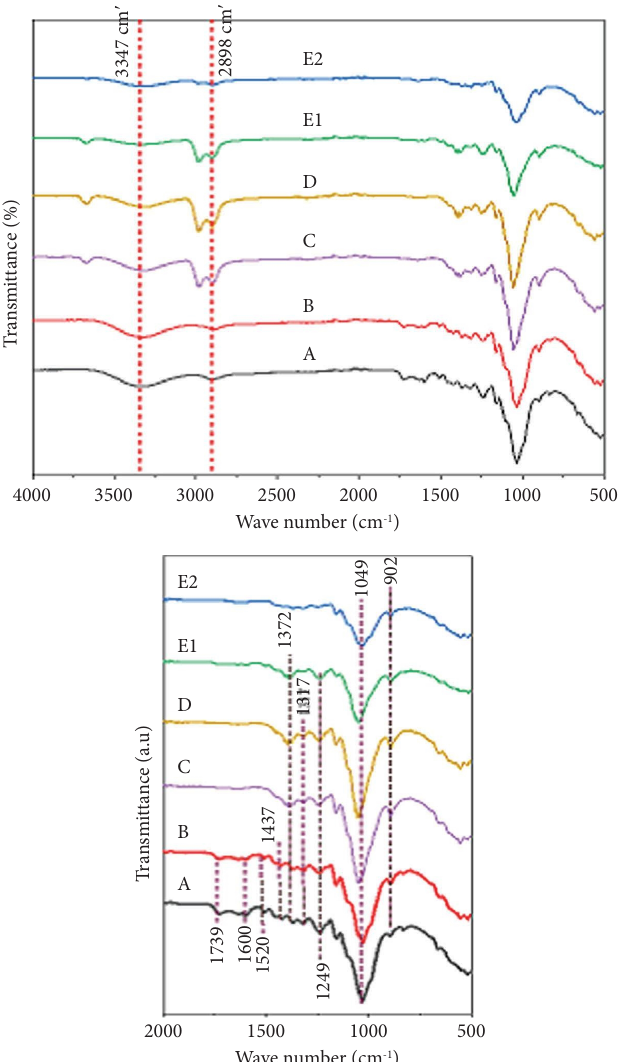
Figure 7: (a, b) FTIR spectra of the extraction of cellulose from sugarcane bagasse.